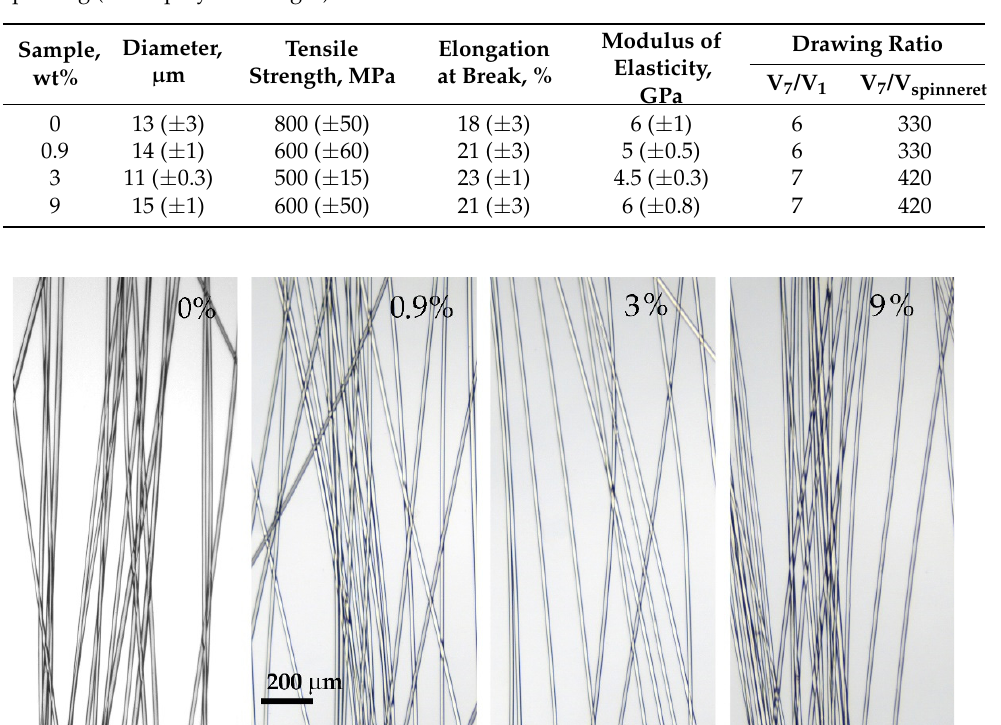
Figure 14. Images of spun fibers made by optical microscopy (at the polymer weight). Of particular interest is the question of the silica distribution into the spun fibers. TEM images of the fiber cross-sections taken with different magnifications are shown in Figure 15.